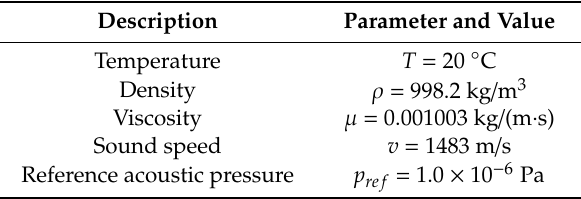
Table 2. Material properties of water used in the simulation.